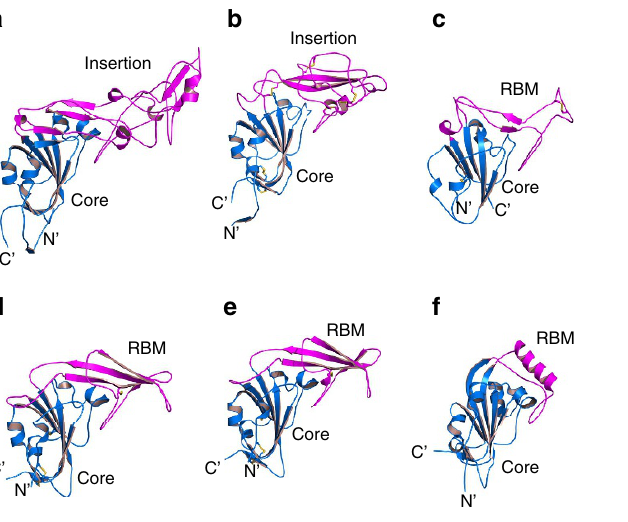
Figure 3 | Structural comparison of CTDs of different b -CoV S proteins. The core subdomains are blue, and the insertion loops are magenta.